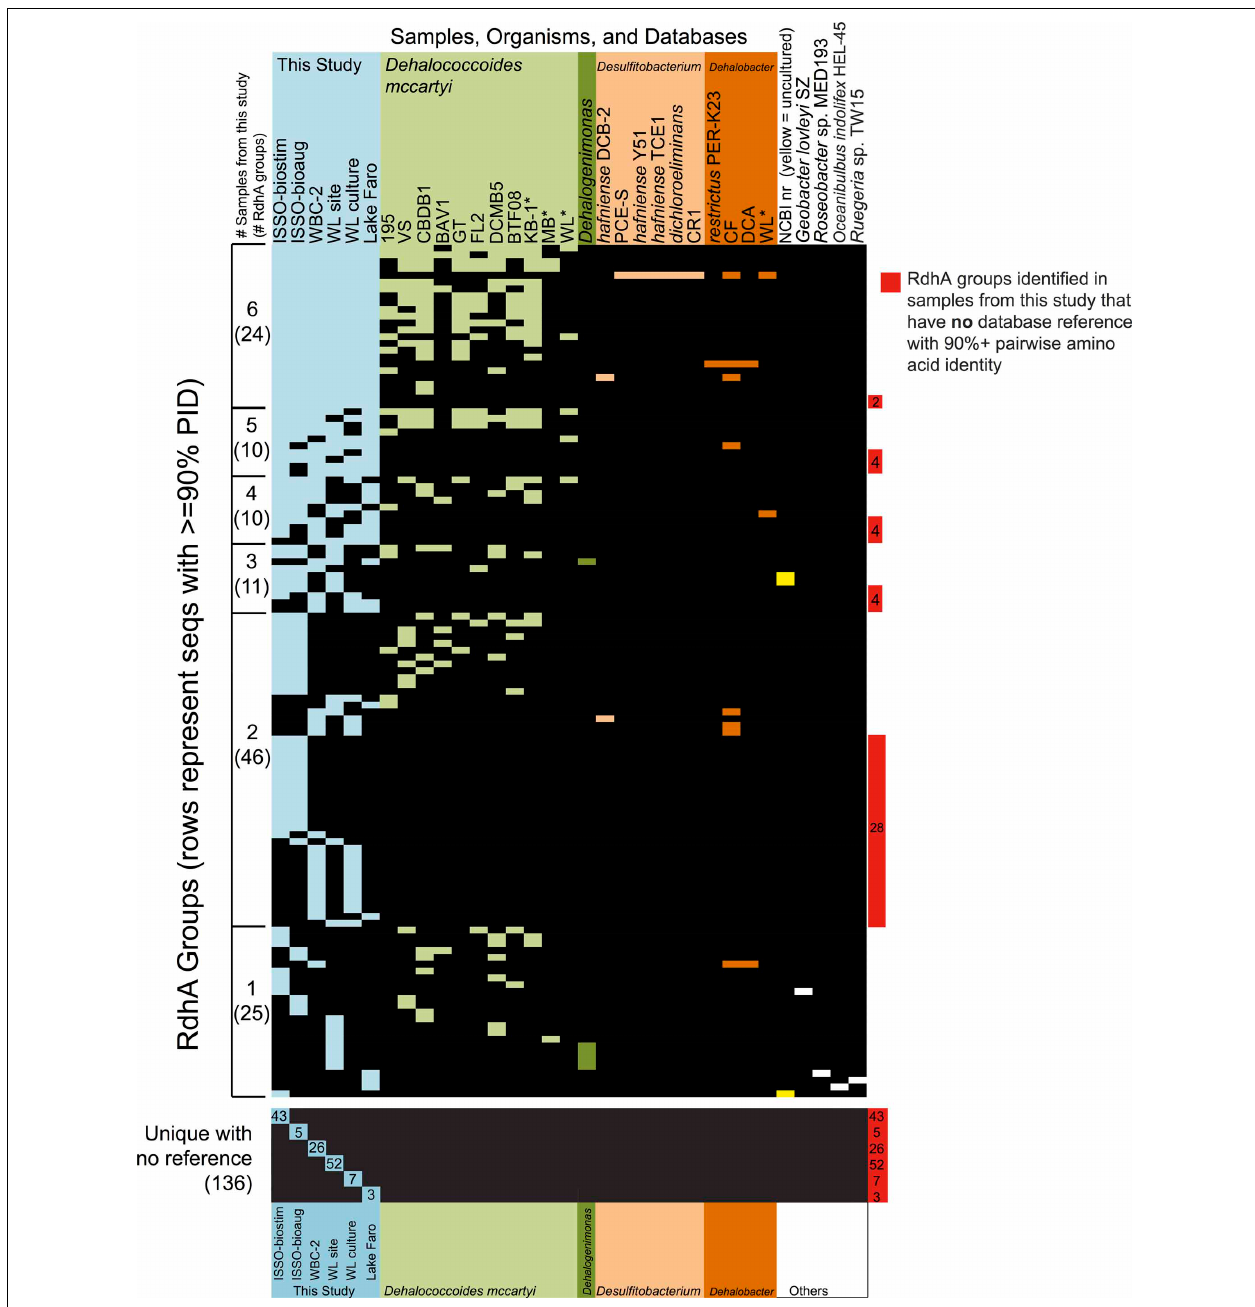
FIGURE 6 | Reductive dehalogenase homologous genes identified from the six samples are broadly distributed and highly diverse. Presence/absence table of the distribution of all RdhA groups, as defined by 90 + % PID between all group members. The table is ordered by the number of samples from this study represented in the group, then by the total number of organisms/samples containing a group member. The first column tallies in parentheses the RdhA groups identified in 6, 5, 4, 3, 2, and only 1 of the samples analyzed in this study, while the columns provide a comparison of the groups’ abundances in sequenced genomes, characterized consortia, and representation in the NCBI nr database. Samples from this study are in